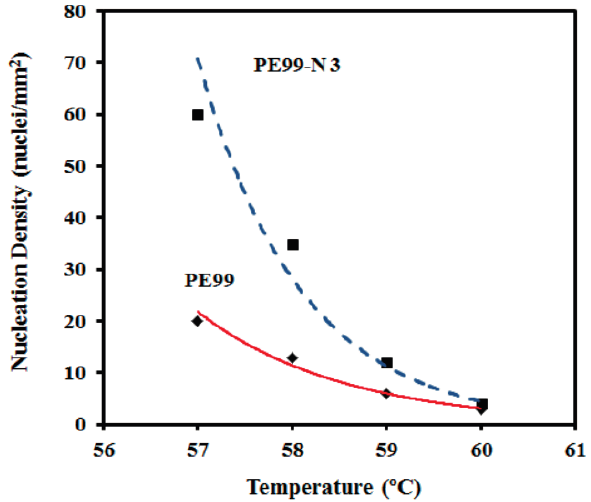
Figure 14. Change in the nucleation density with isothermal crystallization temperature for PE99 ( garnet ) and PE99-N 3 ( blue )